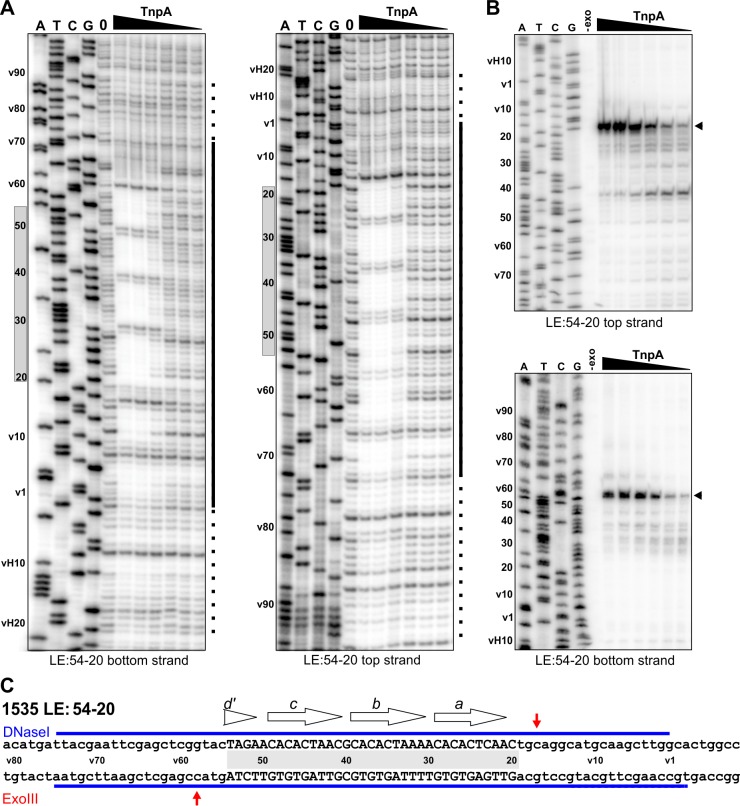
Footprint analysis of IS1535 deletion substrate LE(v54-20v) containing the minimal transposon sequences required for efficient PEC assembly.(A) DNase I footprints of PEC assembly reactions on 5′-32P-labeled bottom and top strands of LE(v54-20v). TnpA concentrations were from 4 to 128 nM in 2-fold increasing amounts. Shaded rectangles on the left of the gels denote the positions of transposon sequences; coordinates labeled with v are vector sequences with vH being the equivalent locations of host DNA. The bars on the right of the gels denote regions of significant changes in DNase I reactivity by TnpA with dashes indicating weakly protected regions. (B) Exonuclease III delineated boundaries of TnpA binding. TnpA concentrations are the same as in panel A. (C) Summary of DNase I (strongly protected regions, blue) and Exo III digestion boundaries on the LE(v54-20v) sequence. Small letters denote vector sequence.